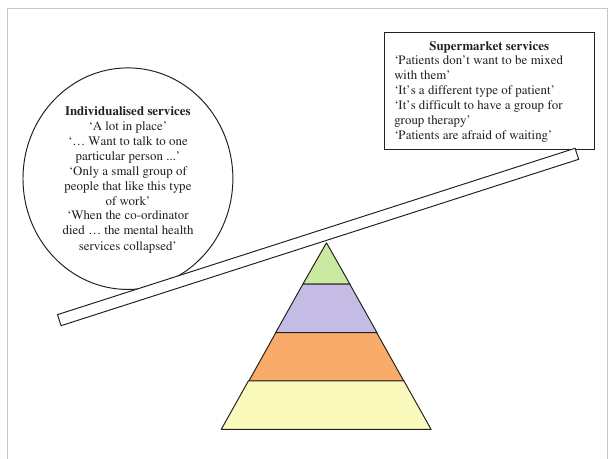
Fig. 2. Individualised versus supermarket approach in mental health care.